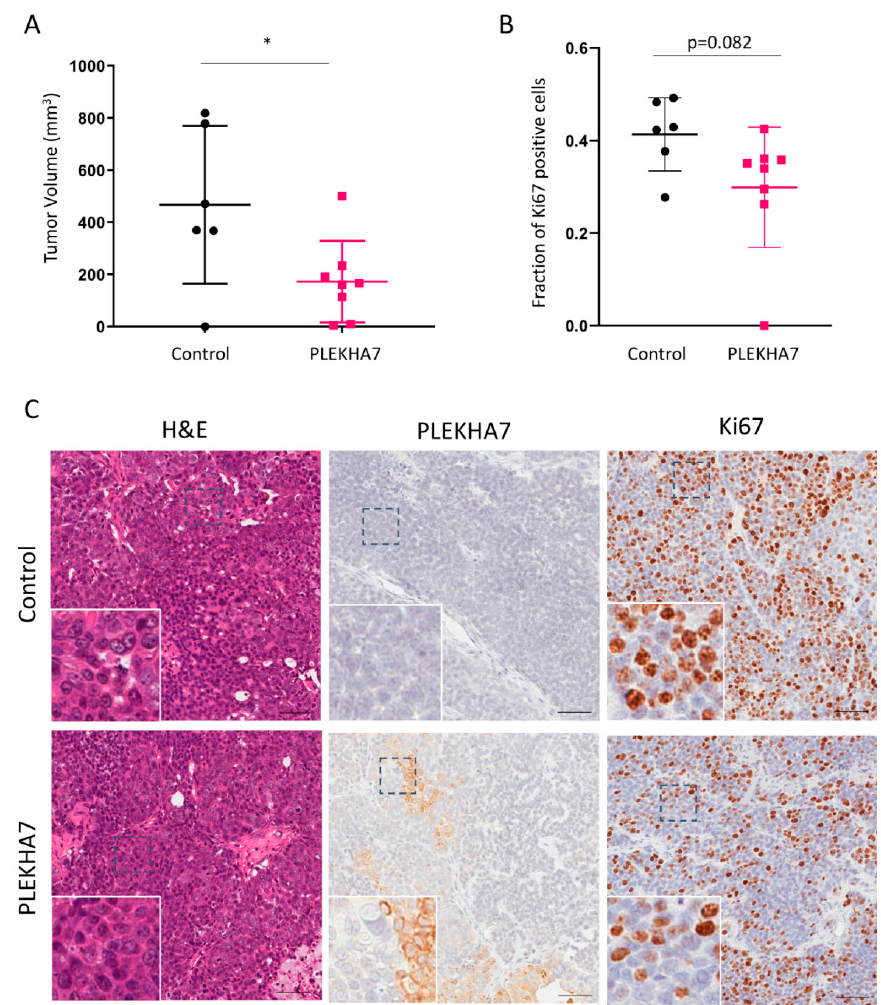
Figure 4. PLEKHA7 effects on SUM149 tumor growth in orthotopic xenografts. ( A ) Tumor volume of xenografts from SUM149 LZRS ms neo (control) or SUM149 LZRS PLEKHA7 cells implanted into the fourth mammary gland of NOD/SCID immunocompromised mice measured at eight weeks post-implantation. * indicates p = 0.034, Student’s t -test. n = 6 for control group, n = 8 for PLEKHA7 group. ( B ) Fraction of Ki-67 positive cells in tumors from SUM149 LZRS ms neo or SUM149 LZRS PLEKHA7 xenografts at the eight week endpoint. p = 0.082, Student’s t -test. n = 6 for control group, n = 8 for PLEKHA7 group. ( C ) Representative IHC images from SUM149 LZRS ms neo or SUM149 LZRS PLEKHA7 xenografts for H&E, PLEKHA7, and Ki67. Scale bar represents 100 µm.